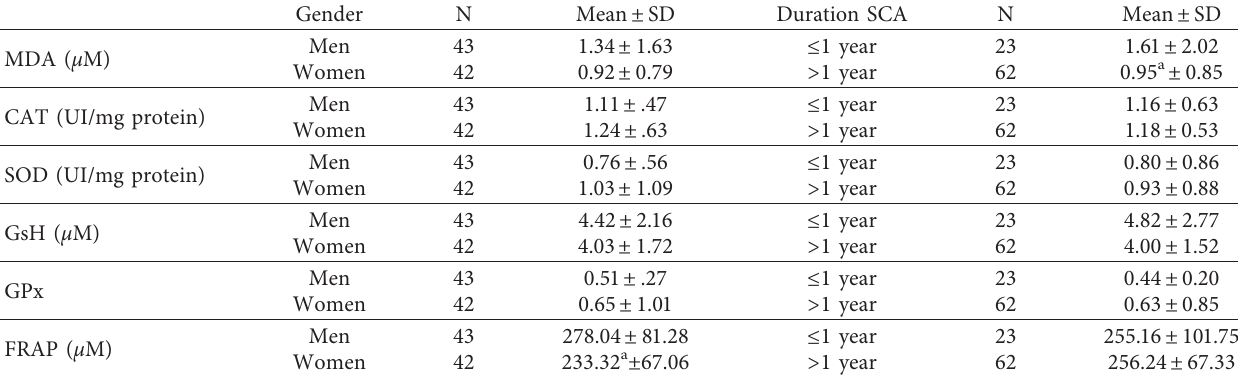
Table 5: Influence of gender and the age of sickle cell anemia detection on the stress profile.